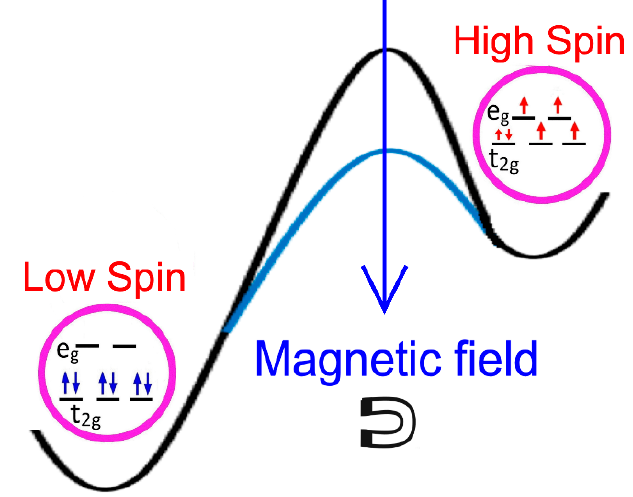
Figure 6. A schematic representation of the reduction in the thermal activation barrier in the pres- ence of a magnetic